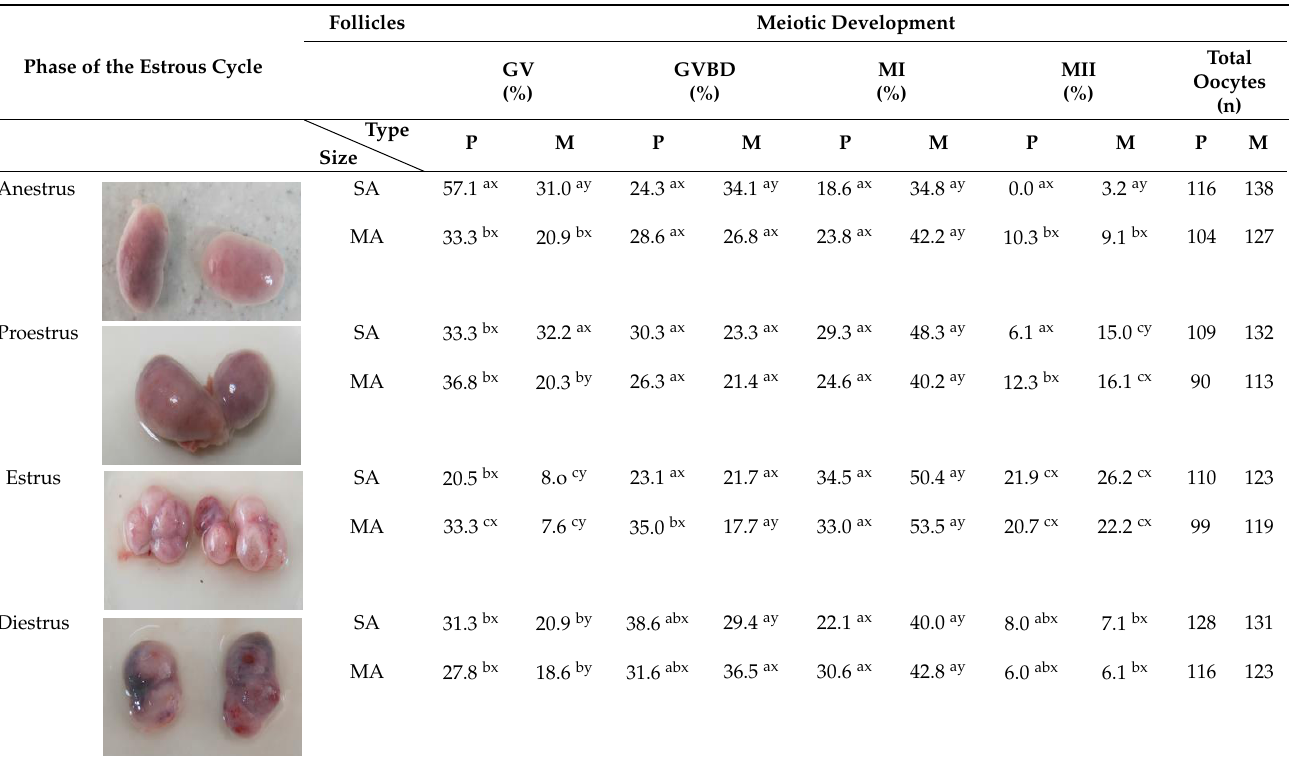
Phase of the Estrous Cycle